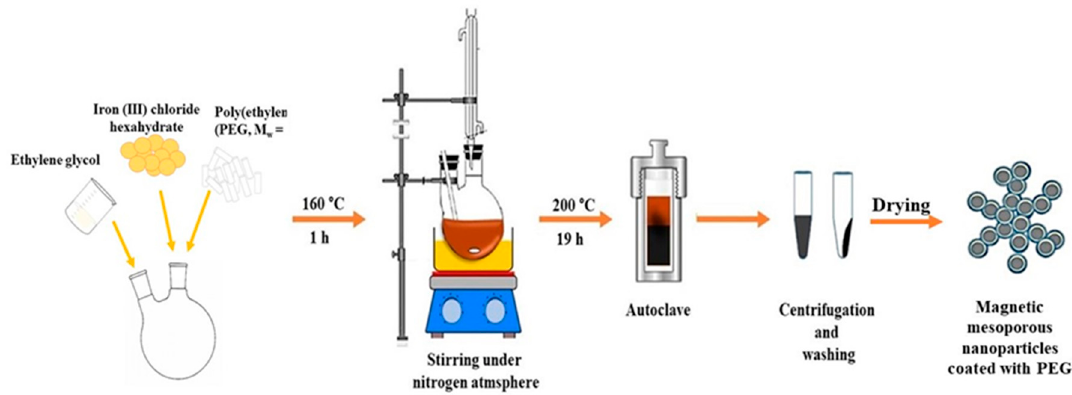
Figure 1. Schematic illustration of mesoporous MNPs preparation using solvothermal